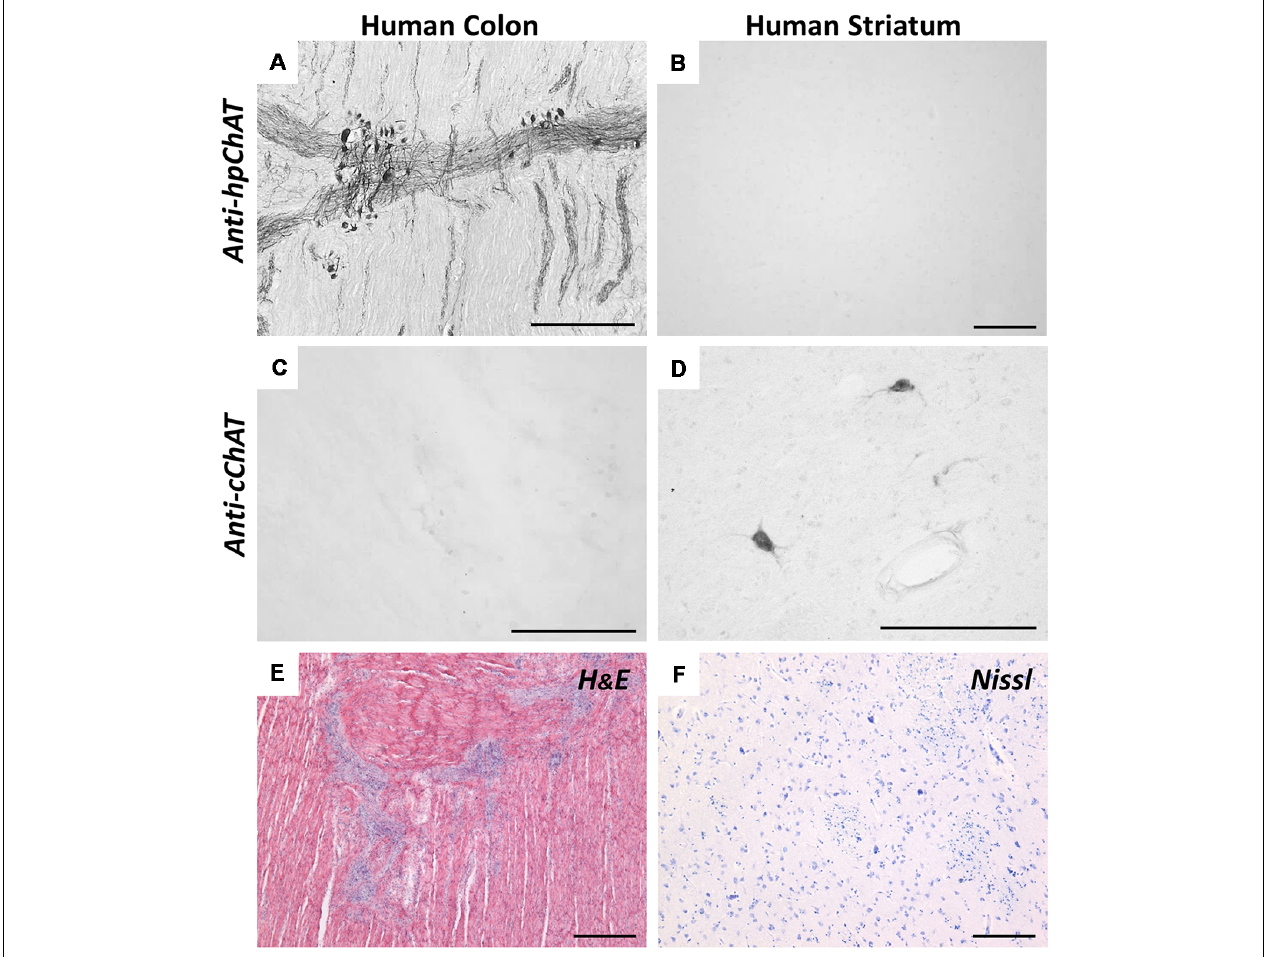
FIGURE 3 | Immunohistochemistry (IHC) using anti-hpChAT (A,B) or anti-cChAT (C,D) sera in human ascending colon (A,C) and striatum (B,D) . Note the specific staining with anti-hpChAT serum in colon, and with anti-cChAT in striatum. Hematoxylin-eosin histological staining in the human ascending colon (E) and Nissl staining in the human striatum (F) . Bars = 200 µ